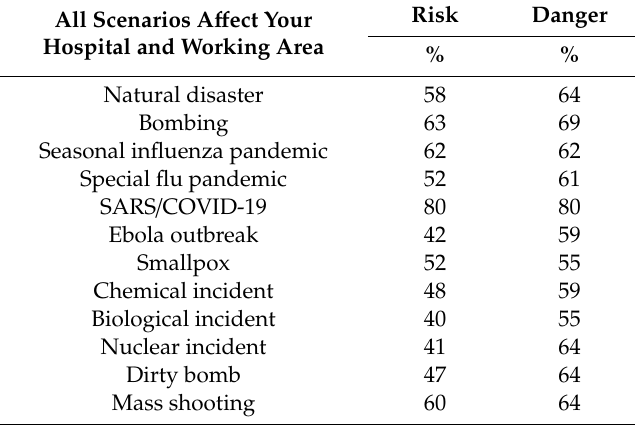
Table 5. Description of risk (0–100% danger when it happens during respondent’s lifetime) and danger (0–100% danger disturbs the whole society and threatens population’s lives and health).